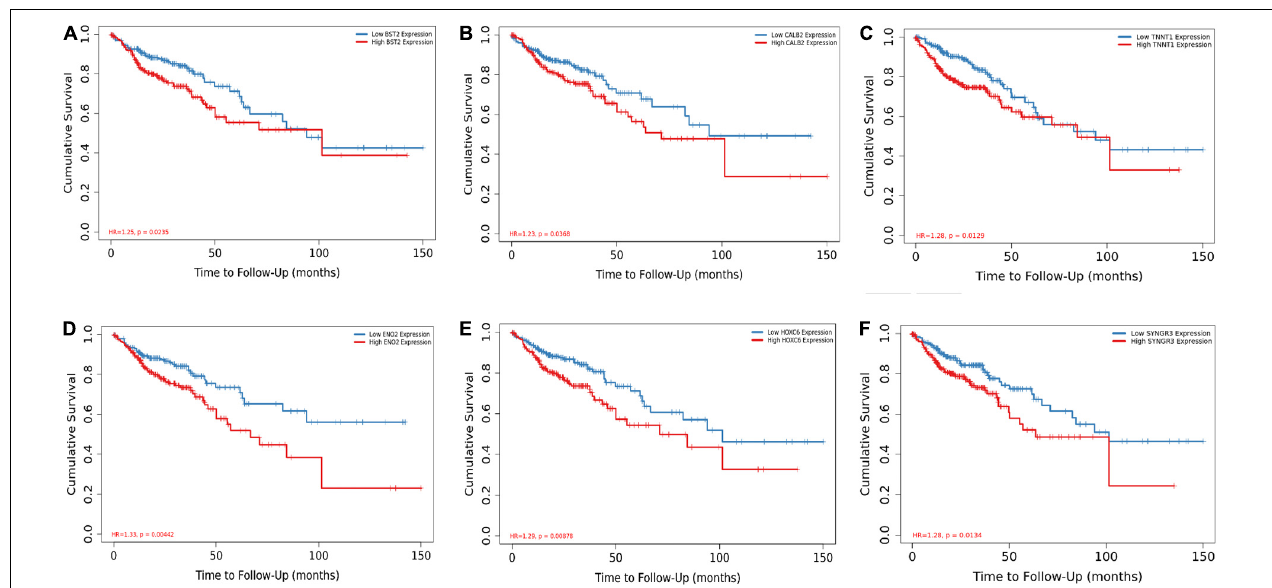
FIGURE 5 | BST2 (A) , CALB2 (B) , TNNT1 (C) , ENO2 (D) , HOXC6 (E) , and SYNGR (F) are associated with overall survival. Log-rank test for Kaplan–Meier curves was conducted to assess the association between overall survival and expression